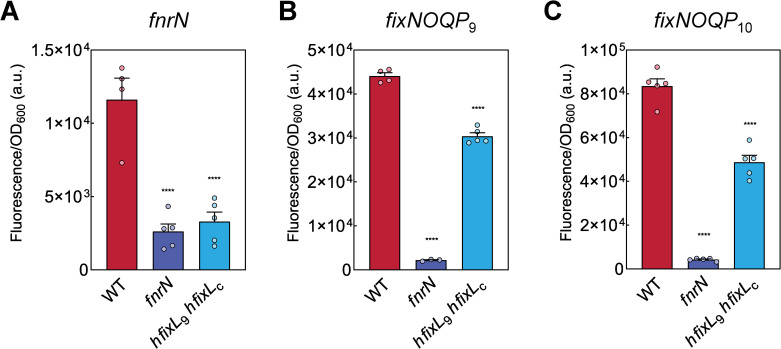
In planta, fnrN is both auto-regulated and controlled by the hFixL-FxkR-FixK pathway, whilst the fixNOQP operons are primarily controlled by FnrN.Rlv3841 WT and mutant strains (fnrN, LMB648; hfixL9
hfixLc, LMB496) containing promoter fusions to syfp2 for fnrN (pOPS0980), fixNOQP9 (pOPS0978) and fixNOQP10 (pOPS0977) were inoculated on plants and bacteroids isolated for measurements. Expression in bacteroids of fnrN (A) is impaired in the fnrN background where auto-activation cannot take place. Expression of fnrN is similarly impaired in the double hfixL mutant, indicating the hFixL-FxkR-FixK pathway also plays an important role in symbiotic fnrN induction. Expression of fixNOQP9 (B) and fixNOQP10 (C) is significantly reduced in the double hfixL mutant and almost abolished in the fnrN mutant. Thus both FnrN and the hFixL-FxkR-FixK pathway play an important role in the expression of all three genes. Data are averages (±SEM) from at least three plants, ****P < 0.0001; by one-way ANOVA with Dunnett’s post-hoc test for multiple comparisons.